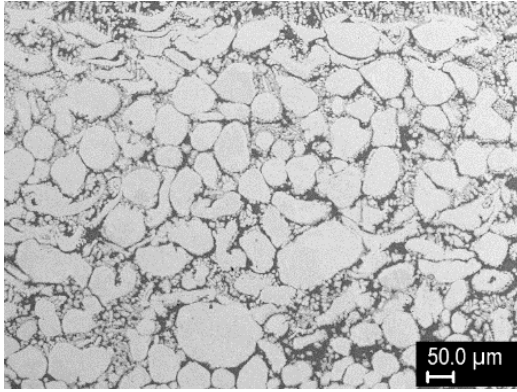
Figure 10. Detail of the W-rich region in the three-layer sample.